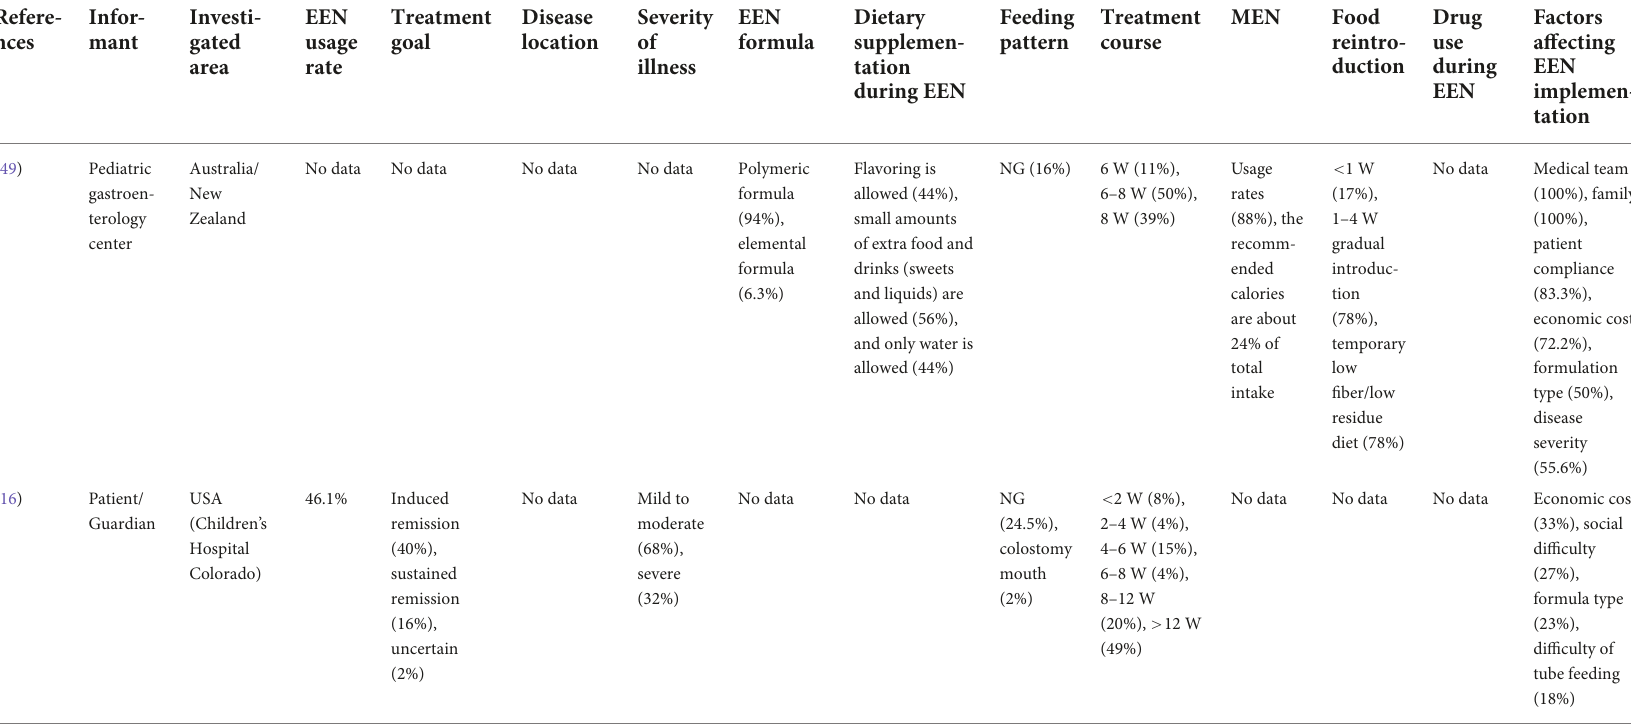
TABLE 1 Global questionnaire survey on exclusive enteral nutrition (EEN) implementation of inflammatory bowel disease (IBD)